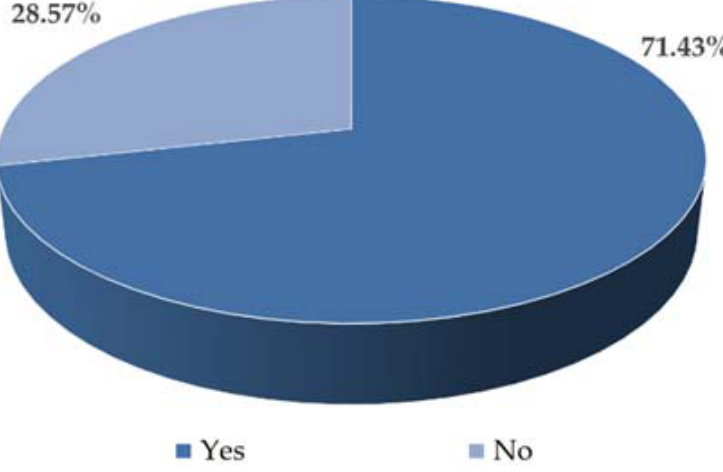
Figure 5. Distribution of respondents’ answers regarding the ease of finding a vacant parking space in an area equipped with vehicle detection devices.